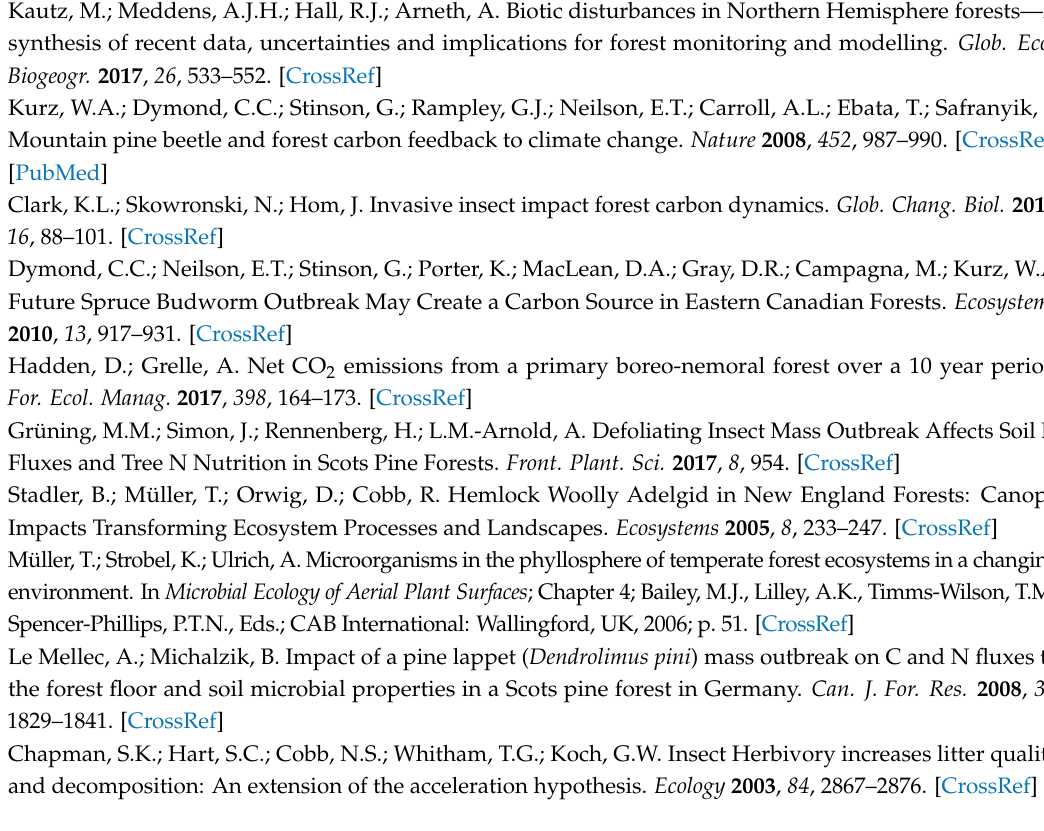
Figure S1: Monthly average precipitation (mm; blue bars) and mean air temperature ( ◦ C; red line) during the sampling period (August 2013–July 2014), Figure S2: Relationship between mean soil CO2-C emissions (mg m − 2 h − 1 ) and soil temperature ( ◦ C of the top 10 cm of soil depth), Table S1: Elemental composition of the mineral soil, Pine-tree lappet ( Dendrolimus pini L.) feces, and Scots pine ( Pinus sylvestris L.) needle litter used in the incubation